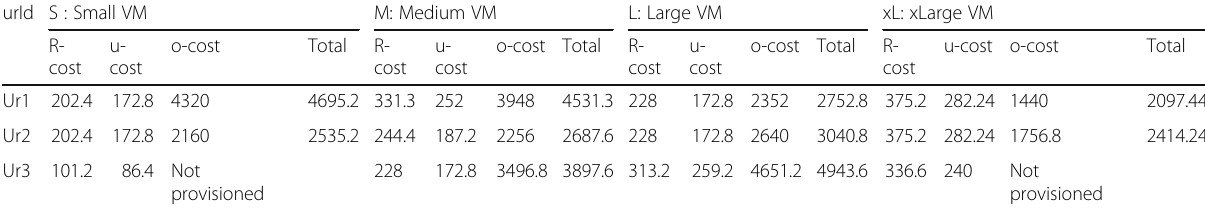
Table 9 A sample of users ’ total resource utilization cost with the non-coordinated provisioning approach urId S : Small VM M: Medium